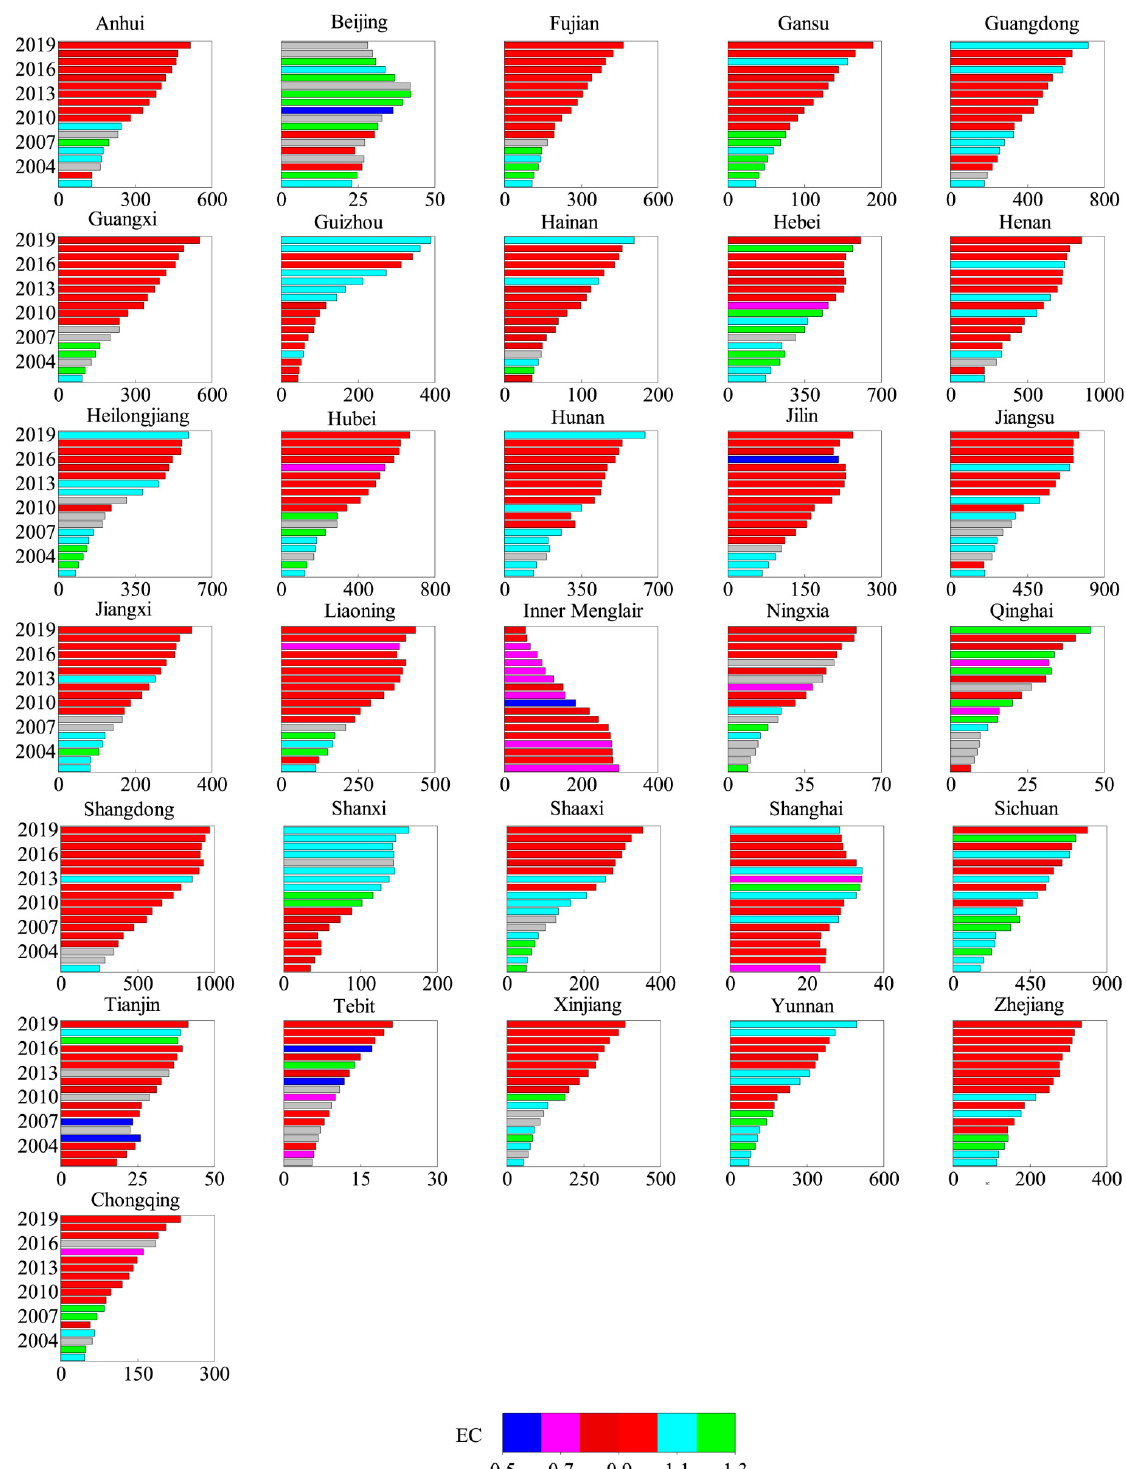
Figure 2. Changes in the composition of TEC values of AGTFP from 2010 to 2019.